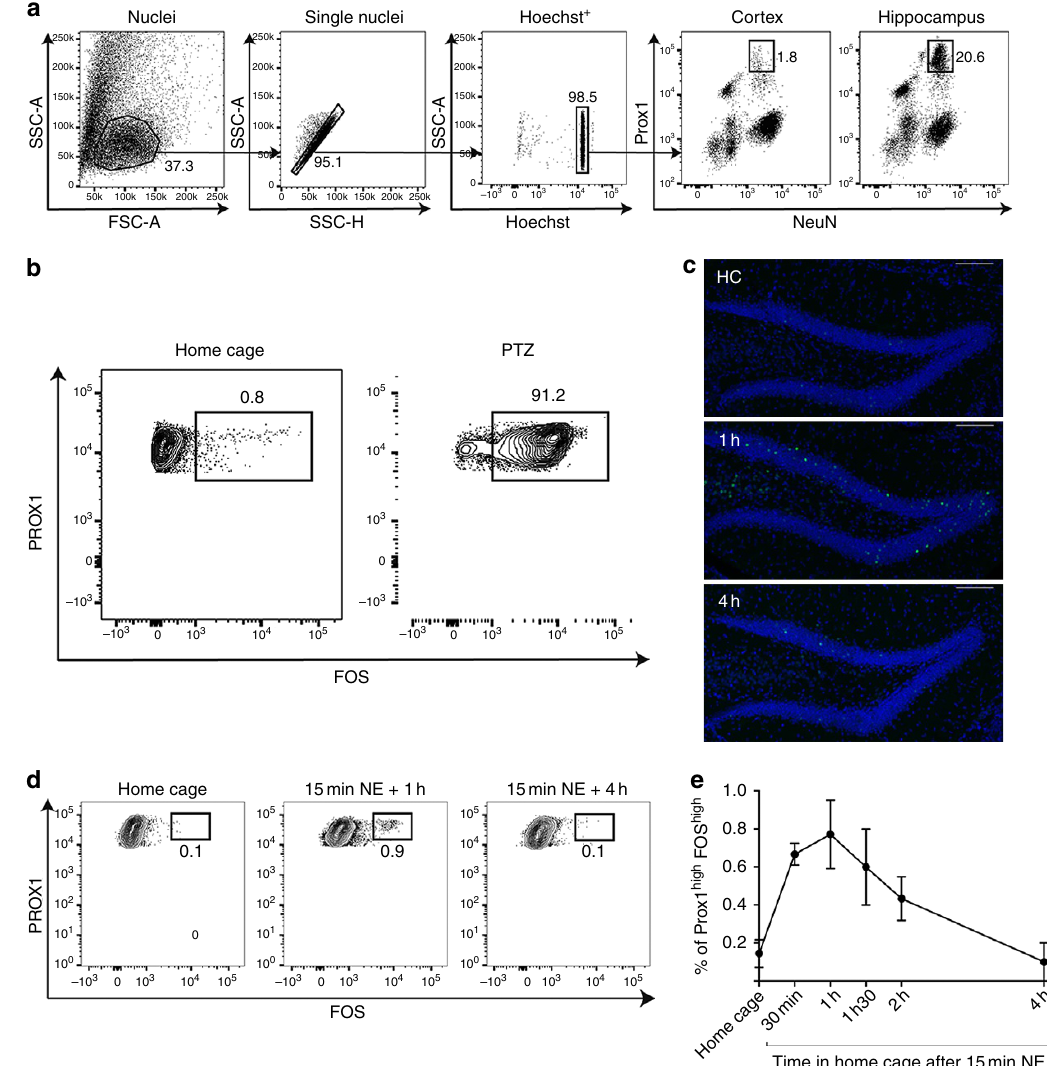
Figure 2 | Detection of experience-associated FOS levels with nuclei staining. ( a ) Representative FACS plots showing the gating strategy for the identification of PROX1 þ NEUN þ DG nuclei in the hippocampus of wild-type mice, n ¼ 3. Staining in cortex is shown as control. ( b ) Representative FACS plots showing FOS protein expression in PROX1 þ Hoechst þ single-nuclei isolated from the hippocampus of PTZ-treated and HC mice, n ¼ 4. FOS protein expression was only observed in PTZ-treated animals. ( c ) Confocal images of FOS protein expression in the DG of a mouse either from home cage (HC) (top) or after recovery from a brief exposure to a novel environment (NE; middle and bottom). One hour after a 15-min exploration period in the NE, FOS was sparsely induced in the granule cell layer (middle). Four hours after NE FOS returned to lower levels similar to HC (bottom). Scale bar, 100 m m. ( d ) Representative FACS plots showing FOS protein expression in PROX1 þ Hoechst þ single-nuclei isolated from the hippocampi of animals from HC, 1h,or 4h after a 15-min exposure to an NE. ( e ) Percentage of PROX1 þ FOS high in the hippocampi of animals from HC 0.5h, 1h, 1.5h, 2h or 4h after a 15-min exposure to an NE, error bars represent standard deviation from the mean ( N ¼ 4 per